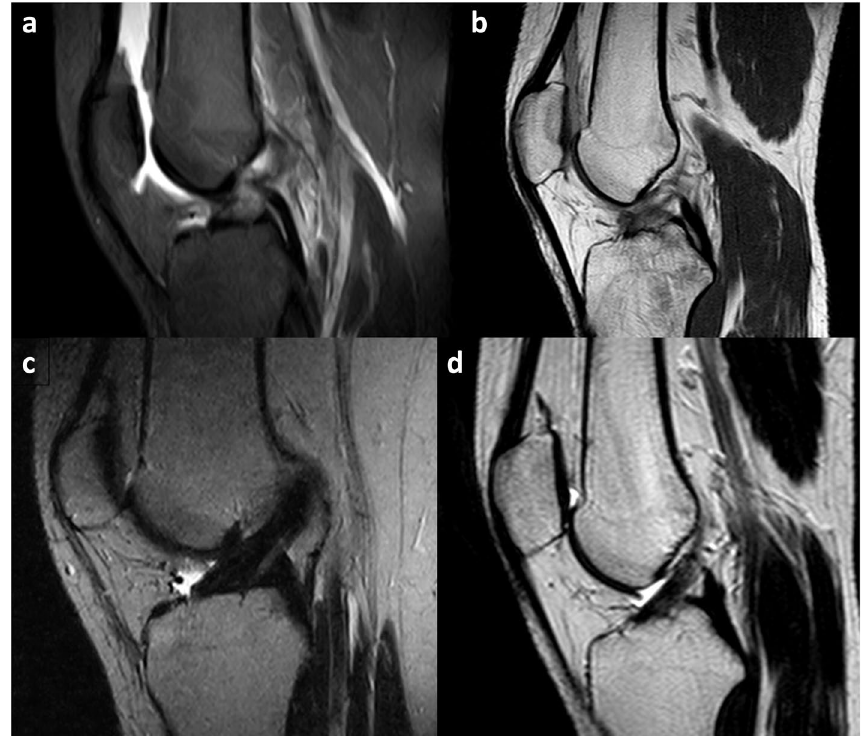
Fig. 2 MRI appearance of patient 1 and patient 3 at the time of diagnosis and six months later, a , First MRI of patient 1 after knee injury in a short tau inversion recovery (STIR) sequence and, b , first MRI of patient 3 in a T2 weighted sequence, showing both swelling, complete discontinuity and increased signal of ACL. c , and d , MRI appearance in T2 weighted sequence of patients 1 and 3, respectively, showing complete recovery of signal intensity and continuity of anterior cruciate